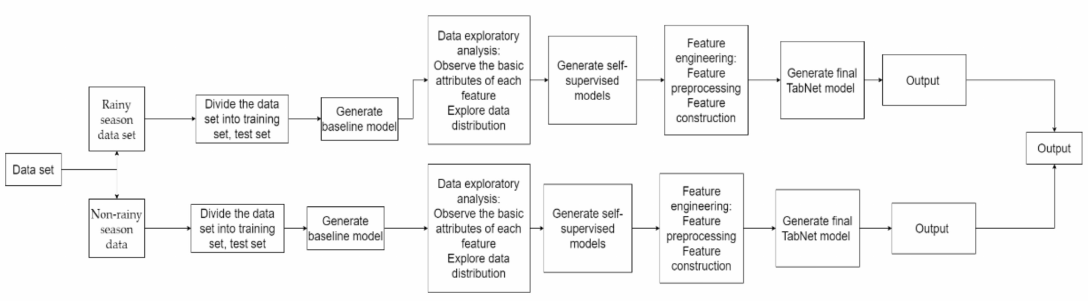
Figure 11. Experiment process.